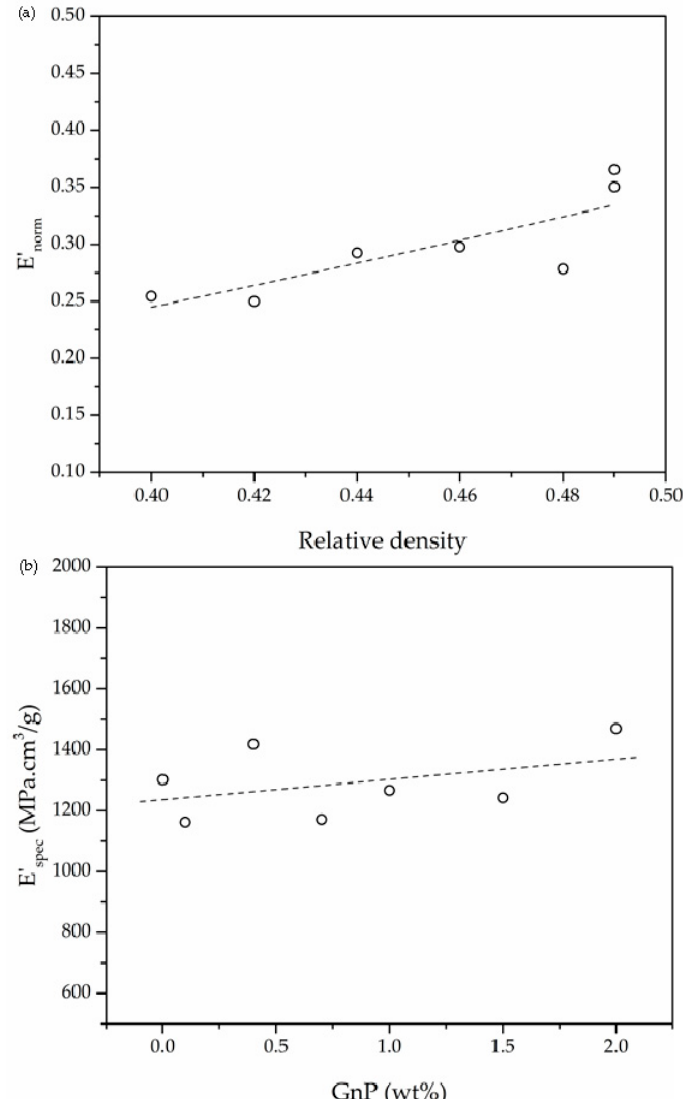
Figure 6. ( a ) Effect of relative density on the normalized storage modulus of PEI and PEI-GnP nanocomposite foams and ( b ) enhancement of the specific modulus with increasing GnP content.